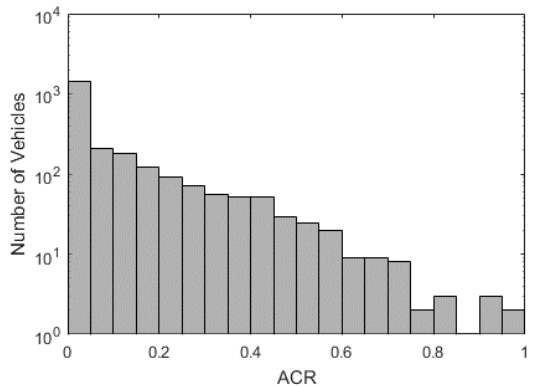
Figure 5. Histogram of all vehicles’ ACR.